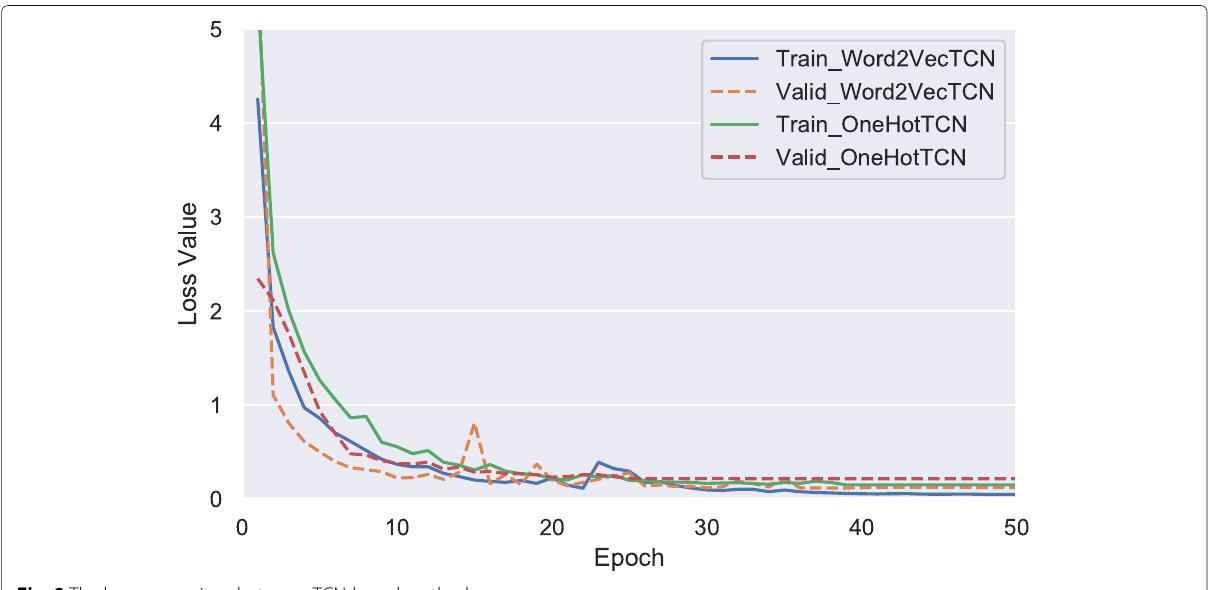
Fig. 9 The loss comparison between TCN-based methods